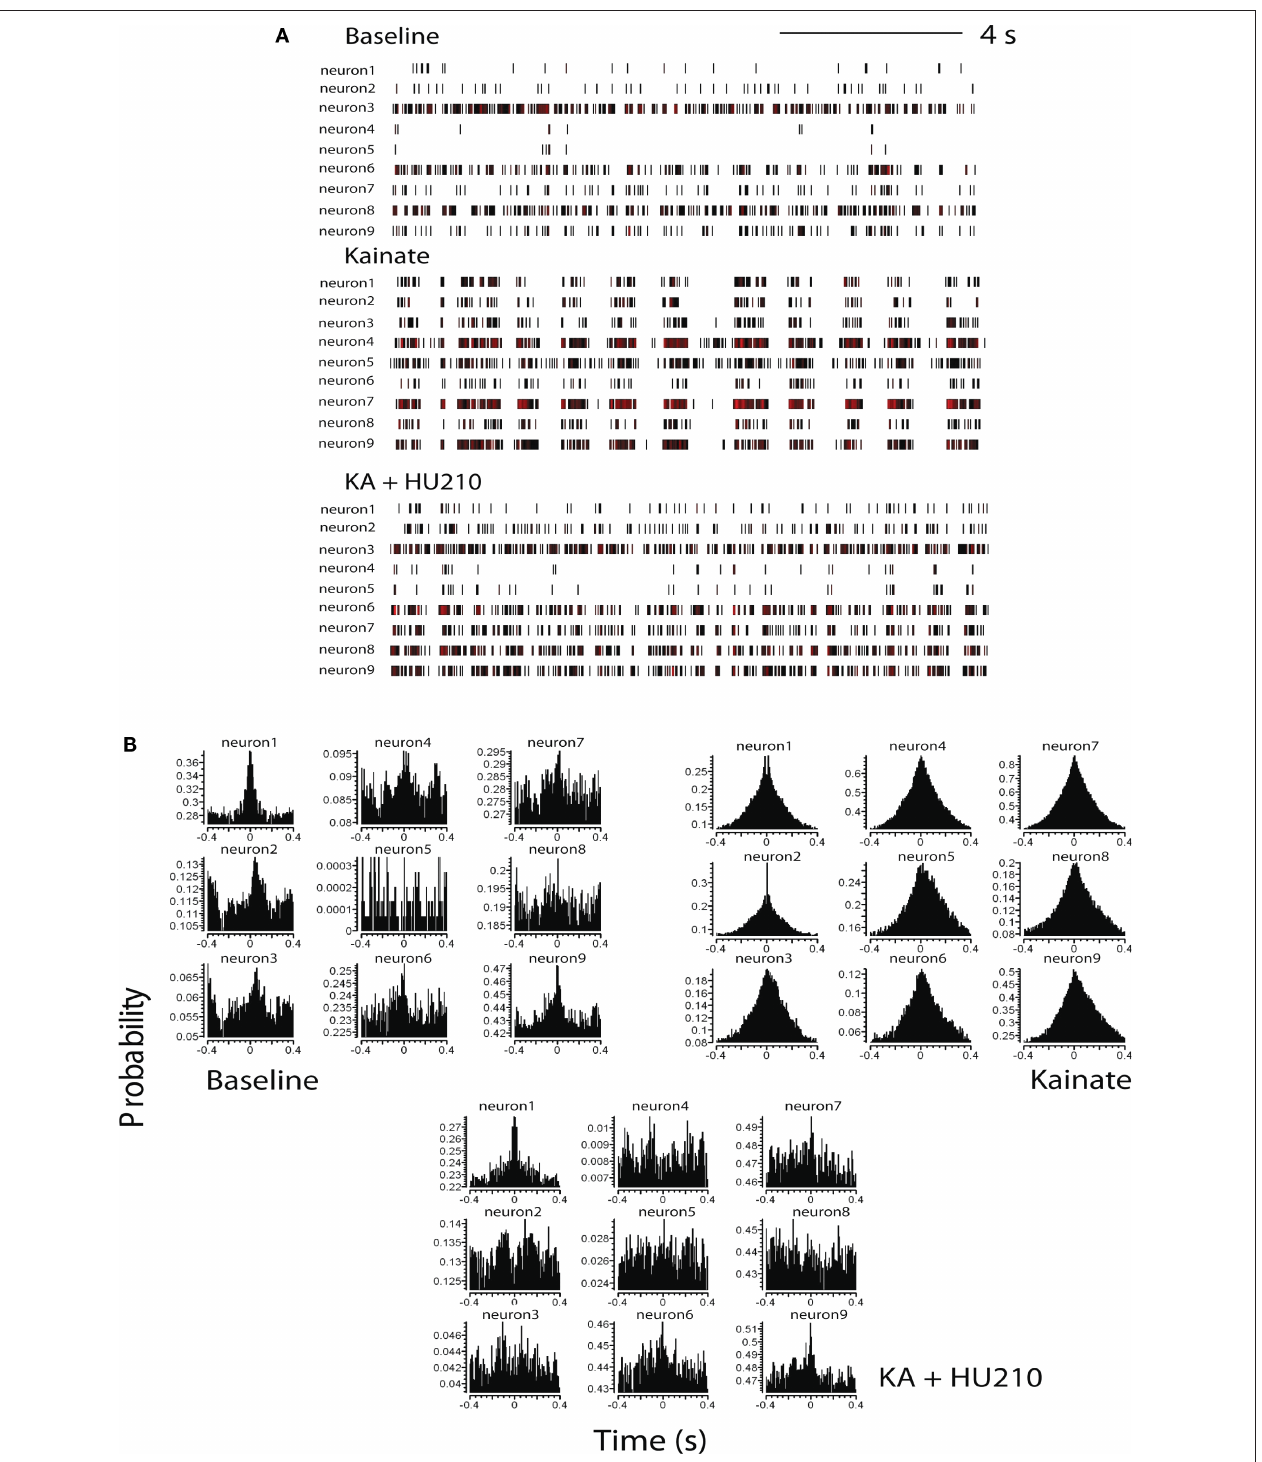
FIGURE 1 | Cannabinoids reverse kainate-induced epileptiform-like activity in the hippocampus. (A) Representative spike rasters for nine simultaneously recorded neurons showing activity during pre-drug basal fi ring (upper panel) and the induction of synchronous burst fi ring induced by kainate (KA; 10 mg kg − 1 ; middle panel). HU210 (100 µg kg − 1 ) reversed the KA-induced synchronous